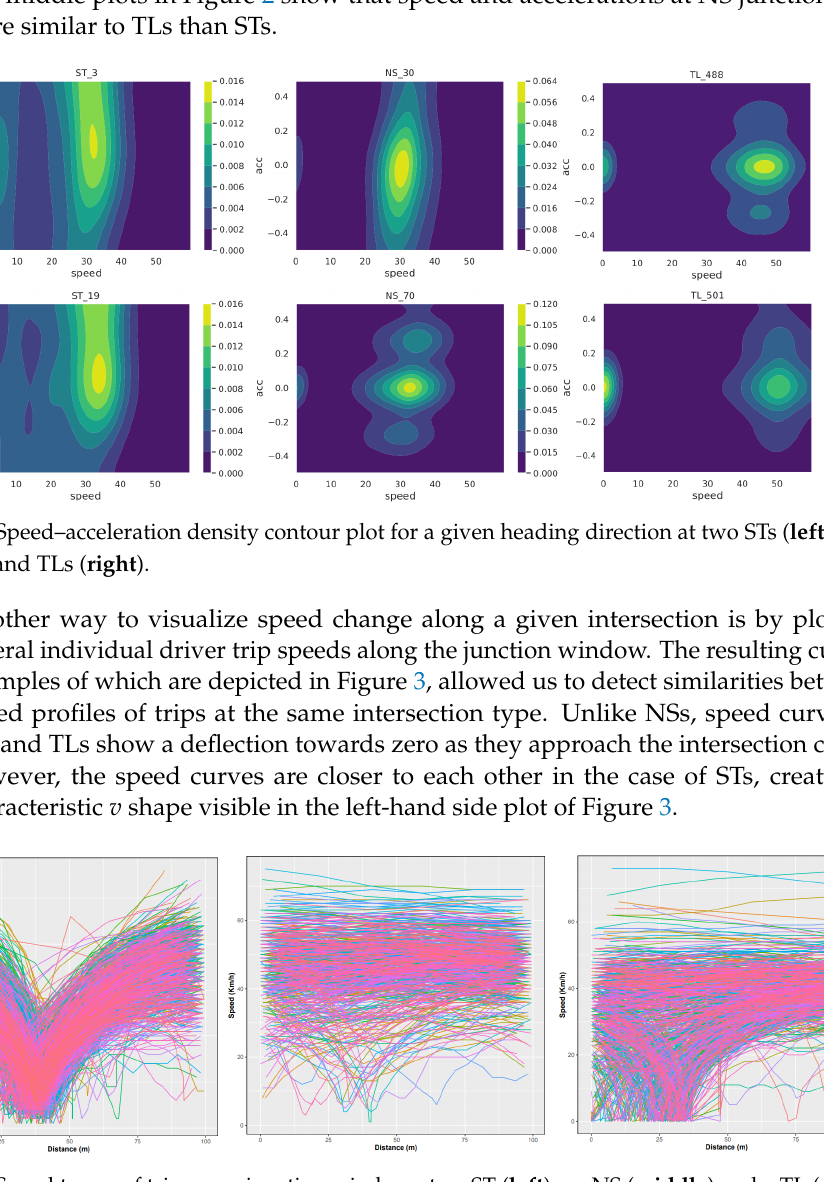
Figure 3. Speed traces of trips over junction window at an ST ( left ), an NS ( middle ) and a TL ( right ).